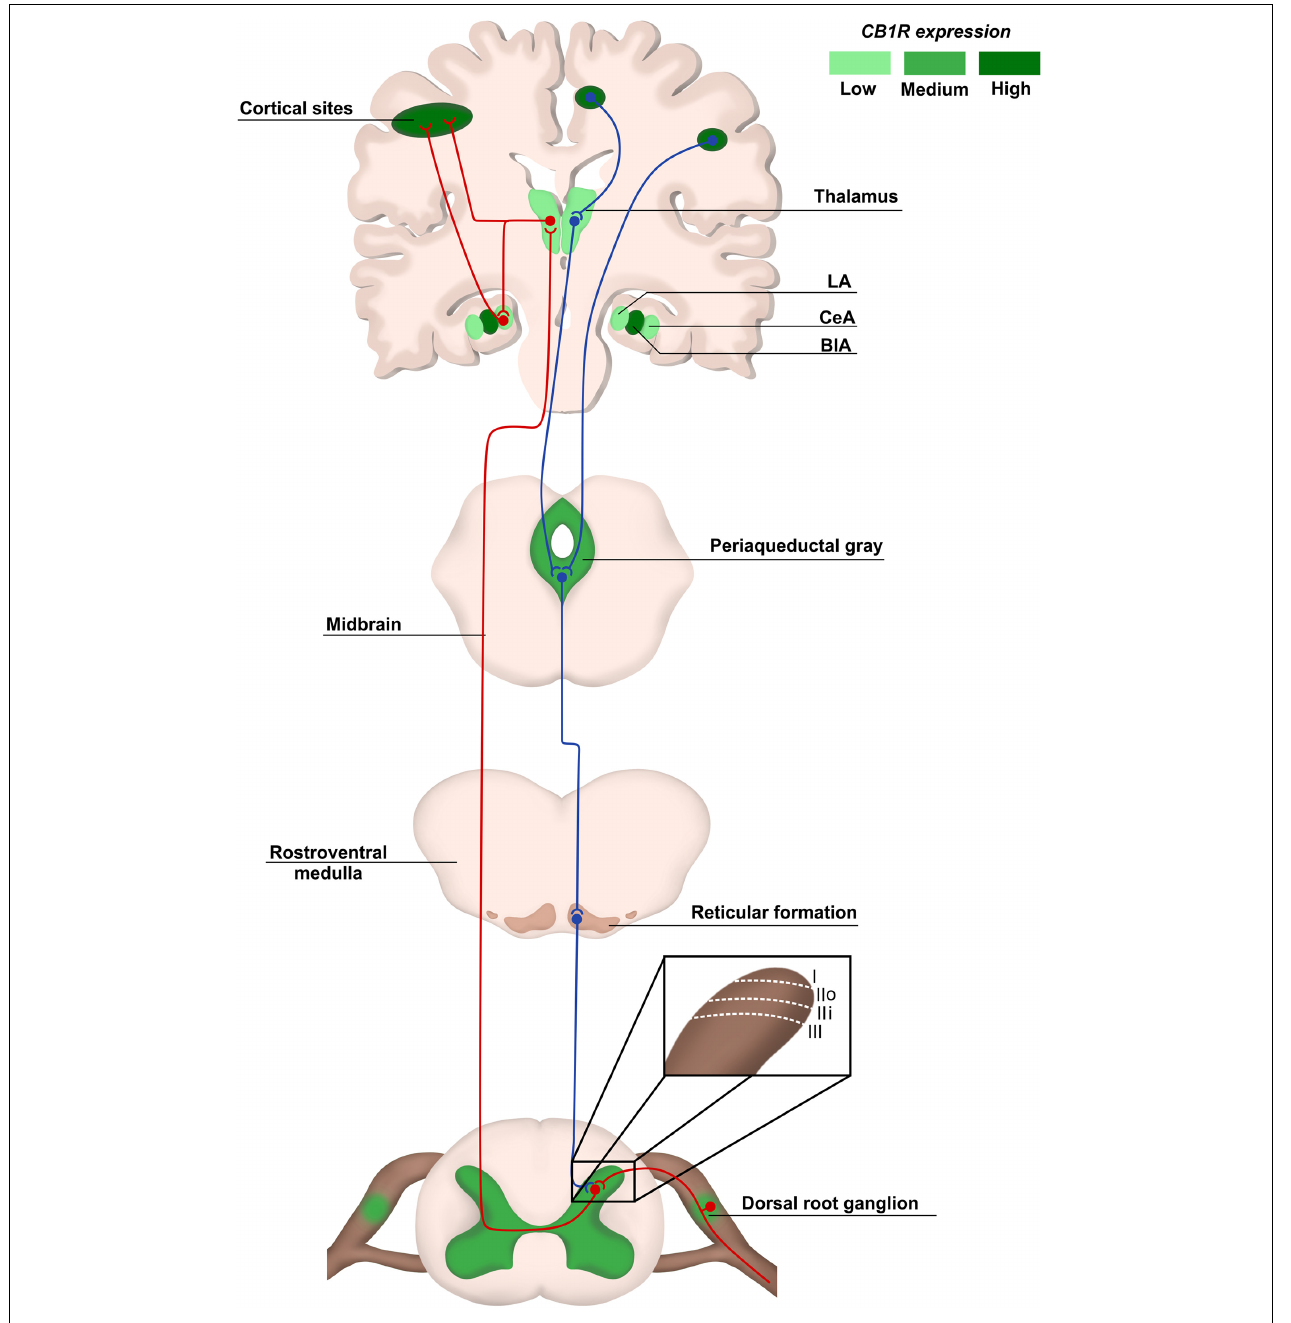
FIGURE 1 | Pain anatomical pathways and CB1R expression. Ascending pain pathways (in red) are carried from the body periphery through sensory neurons of dorsal root ganglia (DRG) that synapse mainly with laminaes I to III in the dorsal spinal cord. Projection neurons make connections with brain areas such as thalamus and cortex. The descending pathways (in blue), responsible for pain modulation, involve areas such as the periaqueductal gray matter and amygdala, ending in the dorsal spinal cord. The CB1R distribution is heterogeneous in pain pathway areas, being more concentrated in regions such as cortex and Central Amygdala (CeA). LA, lateral amygdala; CeA, central amygdala; BlA, basolateral amigdala.